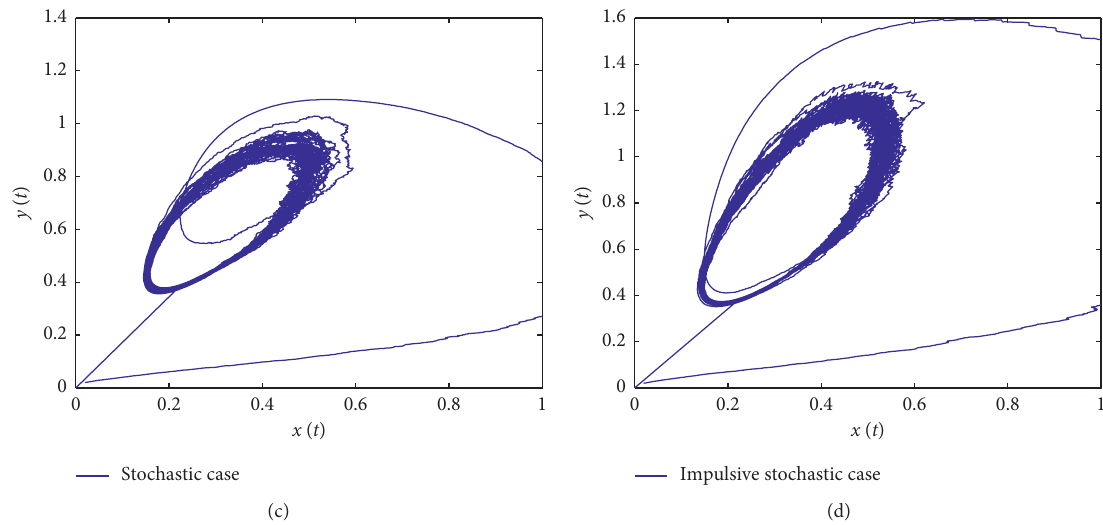
Figure 6: Periodic Markovian process of (5) with n � 2 and x ( 0 ) � y ( 0 ) � 0 . 02. (a) The phase graph of deterministic system � 0 , σ ( t ) � 0 , i � 1 , 2 ) . (b) The phase graph of impulsive system ( σ ( ξ ik i (